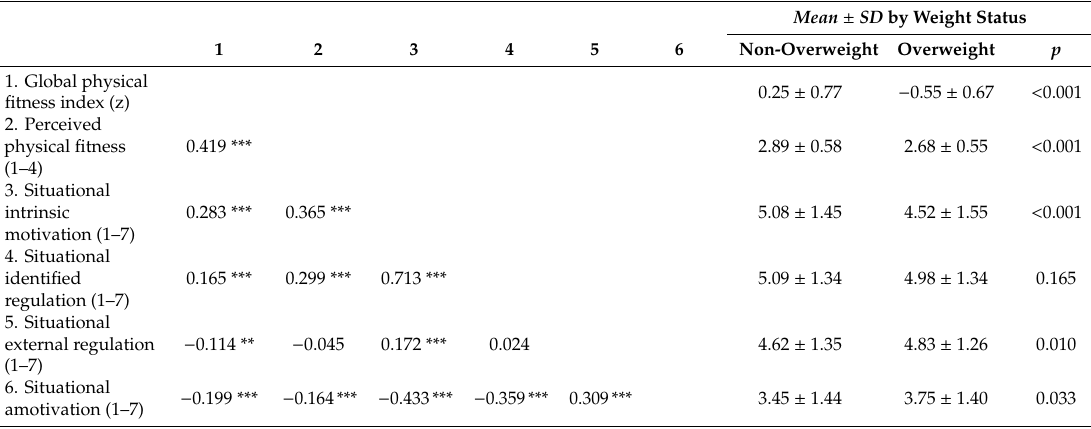
Table 2. Correlations and di ff erences by weight status for global physical fitness index, perceived physical fitness and motivation associated with fitness testing in physical